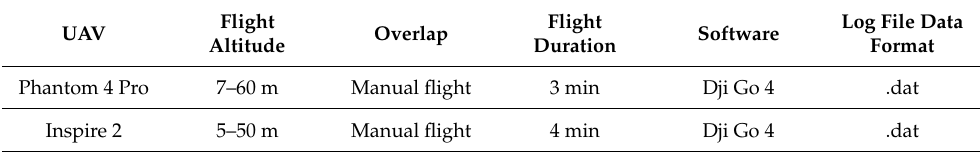
Table 5. Flight details for University Hill dataset.